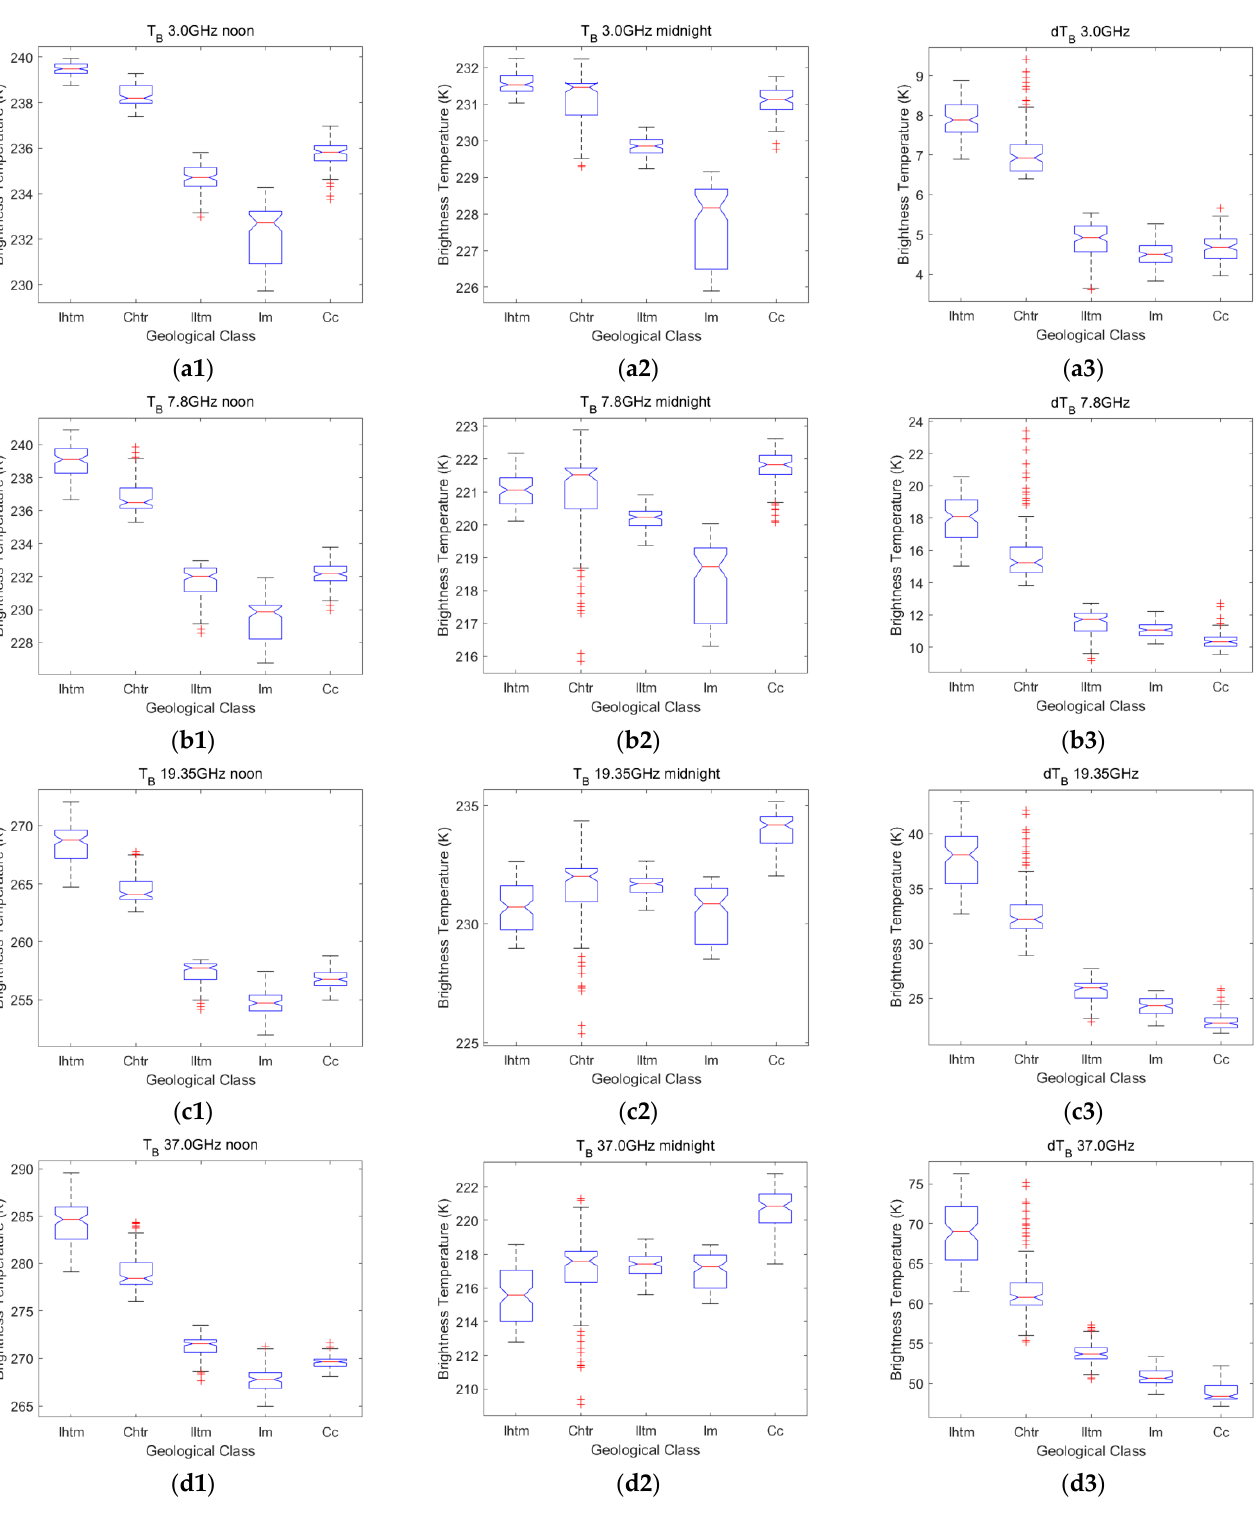
Figure 8. Boxplot of T B and dT B features in 5 sample units of Mare Fecunditatis. ( a ) 3.0 GHz T B fea- tures; ( b ) 7.8 GHz T B features; ( c ) 19.35 GHz T B features; ( d ) 37.0 GHz T B features; ( 1 ) T B noon features; ( 2 ) T B midnight features; ( 3 ) dT B features.